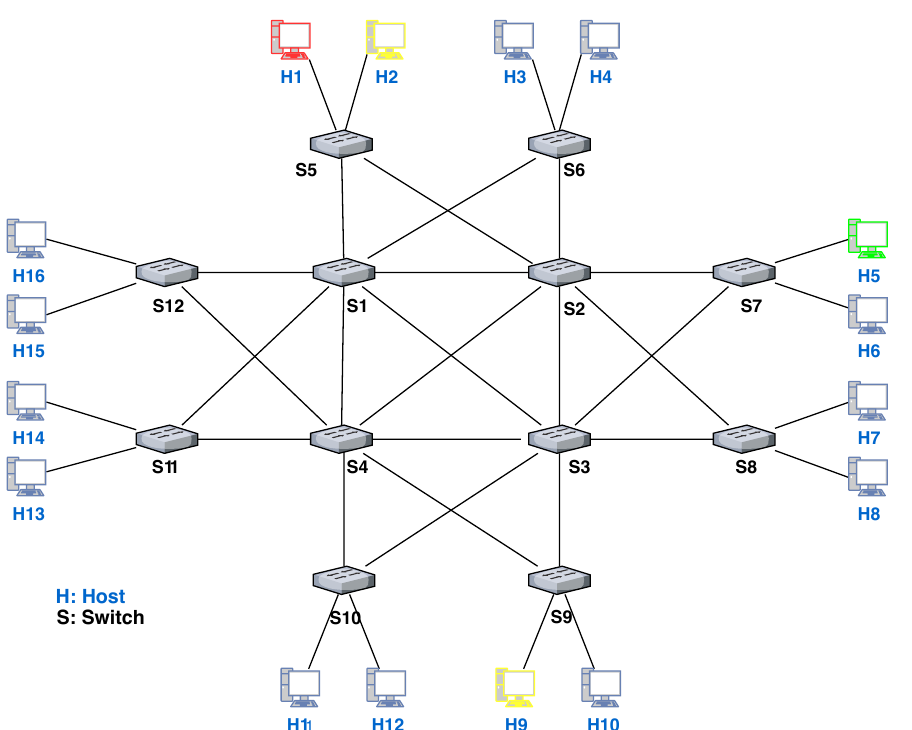
Figure 3. Topology used to generate an extensive synthetic dataset for training of classifier. Core: S1–S4, Edge: S5–S12, and Hosts: